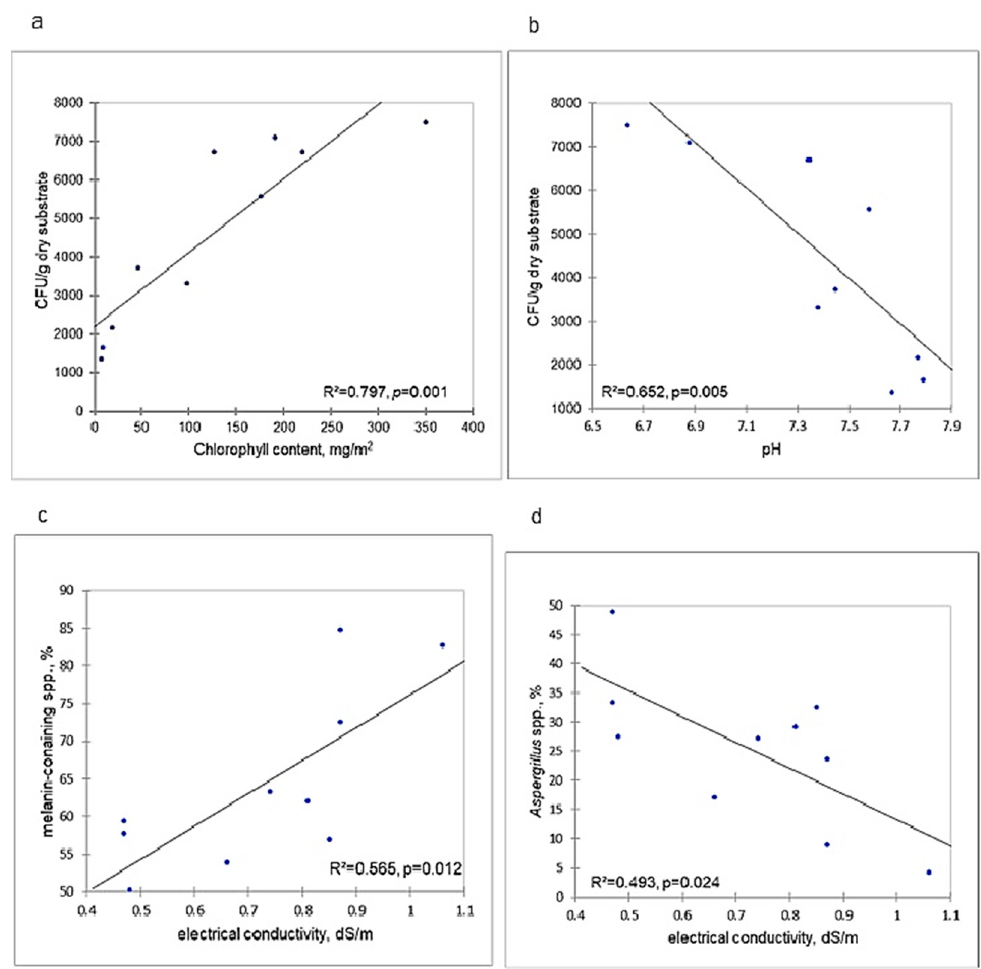
Figure 8. Relationship between characteristics of microfungal communities and measured edaphic parameters in di ff erent crust types and bare surface at the Tabernas Desert. CFU: Colony forming